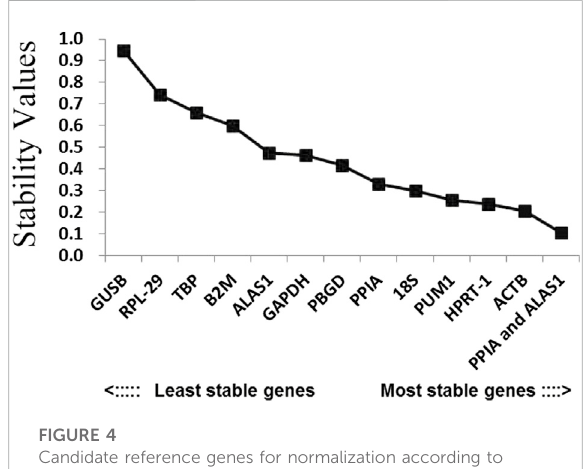
FIGURE 4 Candidate reference genes for normalization according to their expression stability calculated using the NormFinder program. The y -axis represents the stability value. The x -axis from left to right represents the ranking of the reference